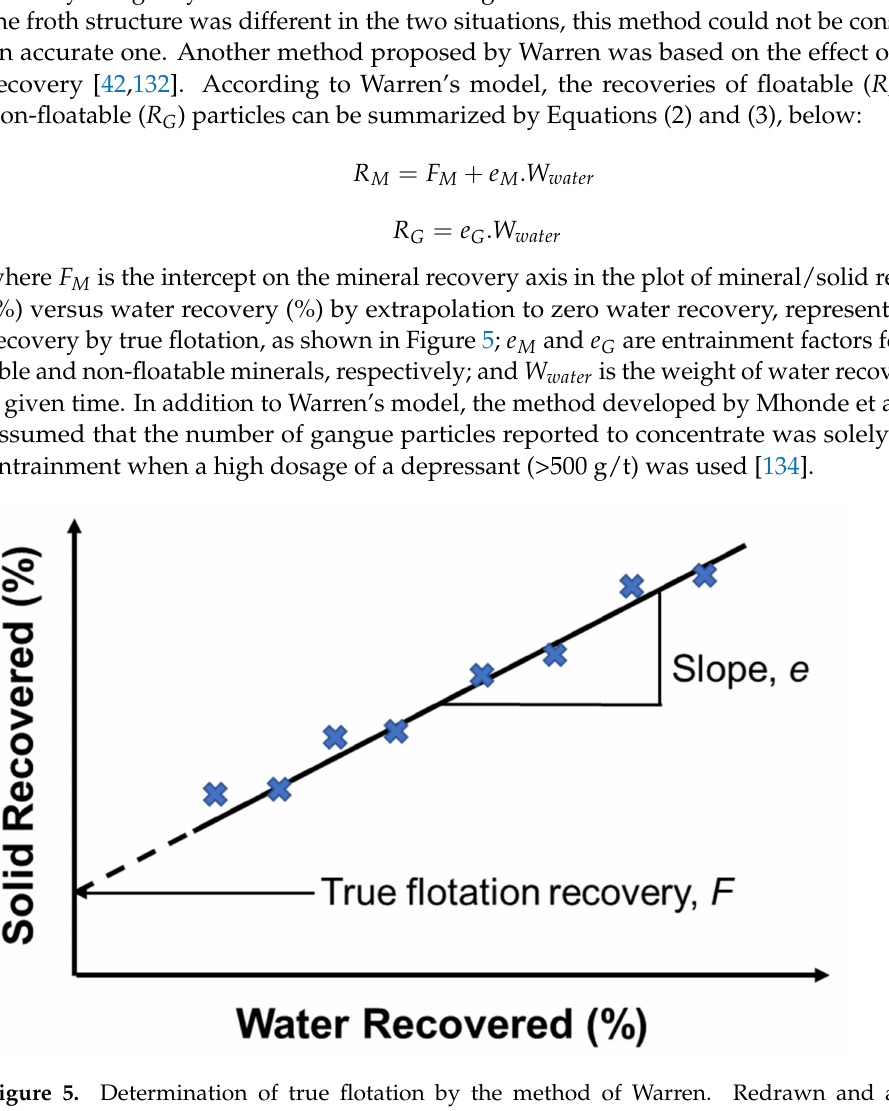
Figure 5. Determination of true flotation by the method of Warren. Redrawn and adapted from